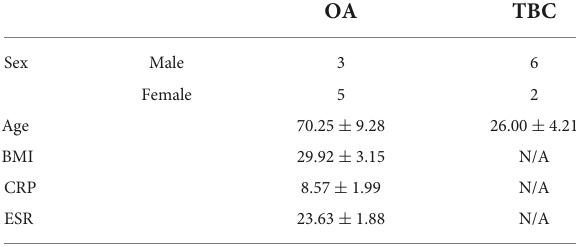
TABLE 1 Demographic and clinical characteristics of